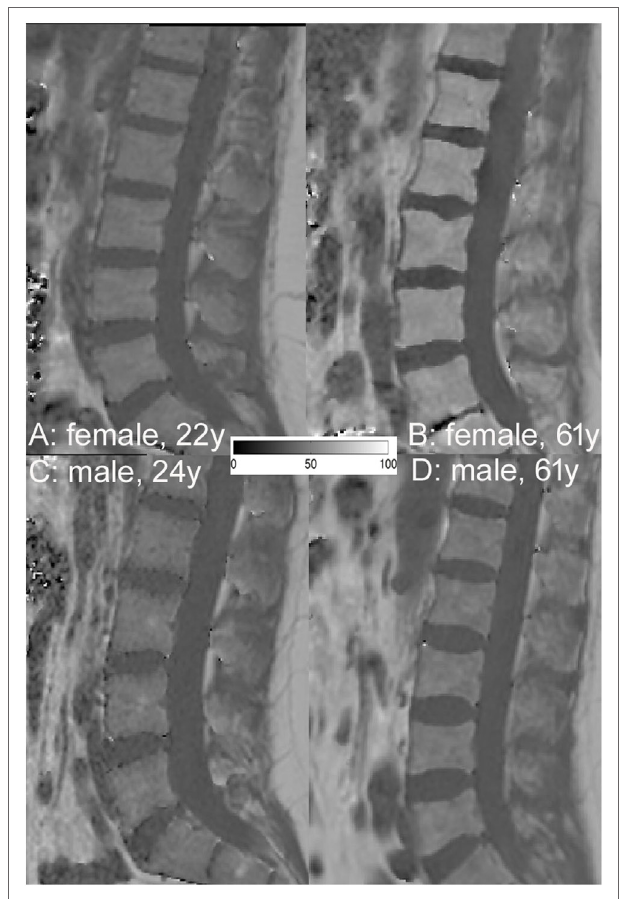
FigUre 3 | Representative proton density fat fraction (PDFF) maps of a 22- (a) and 61- (B) year-old female and a 24- (c) and 61- (D) year-old male subject, respectively. Note the lower PDFF values in A (mean PDFF: 26.2%) than in C (mean PDFF: 29.1%) and the greater PDFF values in (B) (mean PDFF: 62.1%) than in (D) (mean PDFF: